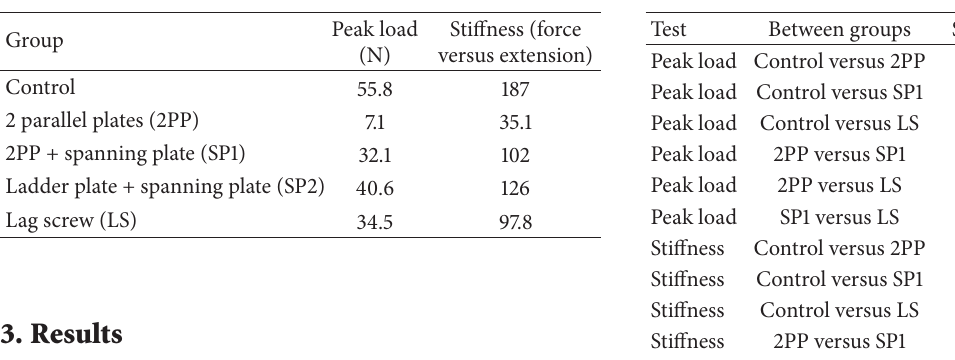
Table 2: Summary of results (mean). Table 3: Statistical analysis